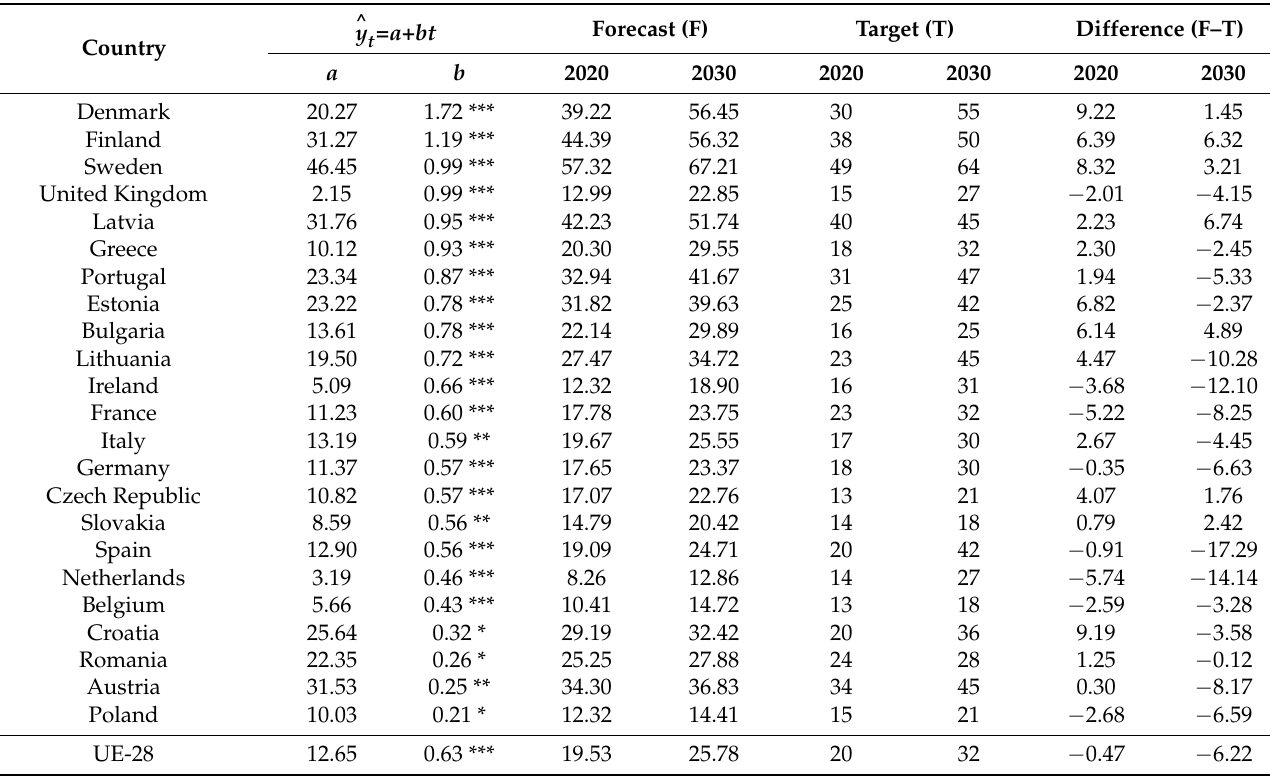
Table 5. Development trend models share of renewable energy in gross final energy consumption (%) and EU country . projections estimated from time series 2010–2019 ( y t ) t = 1,...,10 ^ y = a + bt Forecast (F) Target t Country